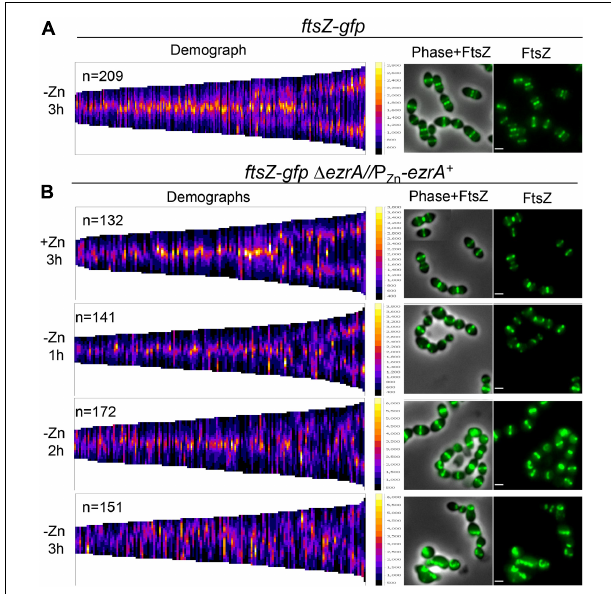
FIGURE 4 | Severe defects in FtsZ-GFP localization upon EzrA depletion in live cells. FtsZ-GFP was localized in live wild-type cells [ ftsZ - gfp ; IU8845 in (A) ] or live EzrA depletion strain [ ftsZ - gfp (cid:49) ezrA// P Zn -ezrA + ; IU8908 in (B) ] grown and visualized in BHI broth at OD 620 ≈ 0.05–0.15 using EFm. EzrA depletion strain was complemented (+Zn; 0.5 mM ZnCl 2 and 0.05 mM MnSO 4 ). Alternatively, EzrA-depleted cells were visualized at 1, 2, or 3 h, upon removal of supplemented Zn/Mn from the BHI broth. Demographs assembled in MicrobeJ (Ducret et al., 2016) showing FtsZ-GFP intensity (left panels) and representative fields (right panels) are shown. Data are from two independent biological replicates in which ( n ) number of cells were analyzed.